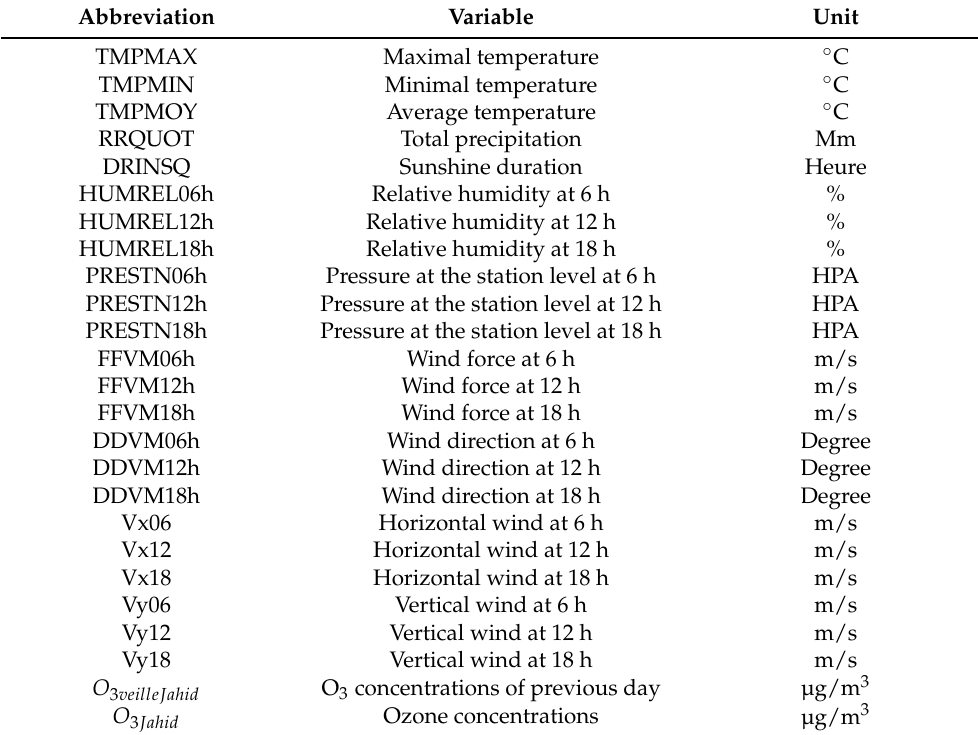
Table 1. Variable abbreviations and units of